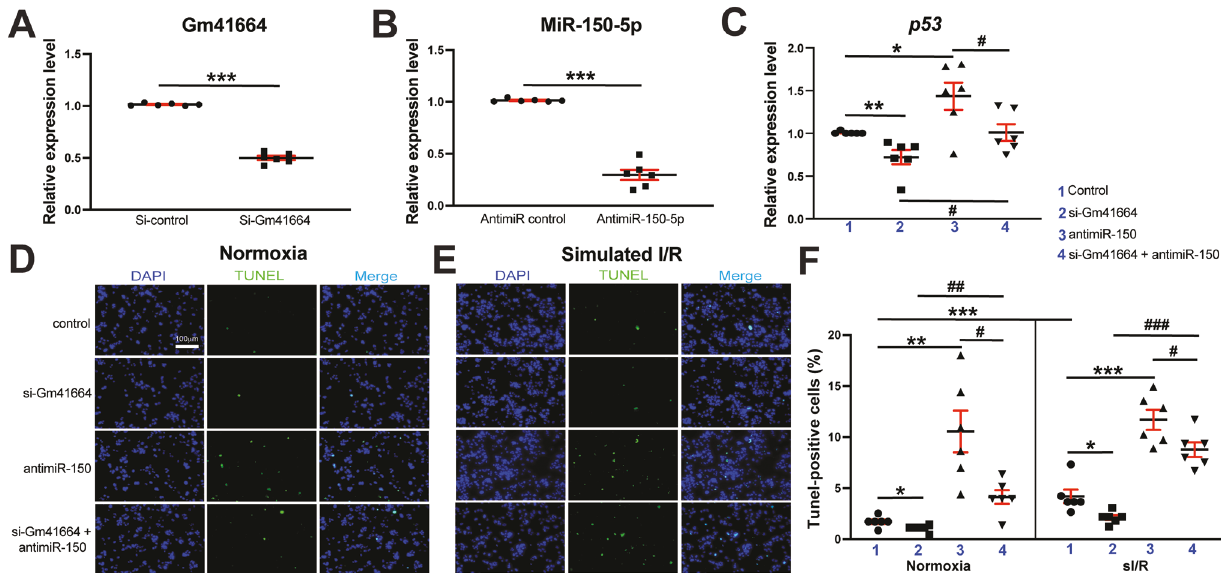
Fig. 7 MiR-150 is required for Gm41664-dependent induction of cardiomyocyte apoptosis. A , B HL-1 cells were transfected with control scramble siRNA (si-control) or Gm41664 siRNA (si-Gm41664) ( A ) and with anti-miR control scramble or anti-miR-150 ( B ). QRT-PCR for Gm41664 ( A ) or miR-150 ( B ) was conducted to check the knockdown ef fi ciency. Data were normalized to Gapdh ( A ) or U6 snRNA ( B ) and expressed relative to controls. N = 6 per group. Unpaired two-tailed t -test. *** P < 0.001 vs. si-control or anti-miR control. C QRT-PCR expression analysis of pro-apoptotic p53 in cardiomyocytes (CMs) transfected with 4 different groups as indicated. N = 6. p53 expression compared to Gapdh was calculated using 2 − ΔΔ Ct , and data are presented as fold induction of p53 expression levels normalized to control (si-control or anti-miR control). One-way ANOVA with Tukey multiple comparison test. * P < 0.05 or ** P < 0.01 vs. control. # P < 0.05 vs. si-Gm41664 + anti-miR-150. D – F MiR-150 knockdown reverses the anti-apoptotic effects of si-Gm41664 in CMs. CMs were transfected as indicated and subjected to in vitro simulation of I/R (hypoxia/reoxygenation) [sI/R (H/R)]. TUNEL assays were then conducted in both normoxic ( D , F ) and sI/R conditions ( E , F ). The percentage of apoptotic nuclei (green) was calculated after the normalization of total nuclei (blue). Scale bar = 100 μ m. N = 6. One- way ANOVA with Tukey multiple comparison test. * P < 0.05, ** P < 0.01, or *** P < 0.001 vs. control. # P < 0.05, ## P < 0.01, or ### P < 0.001 vs. si- Gm41664 + anti-miR-150. All data are presented as mean ±